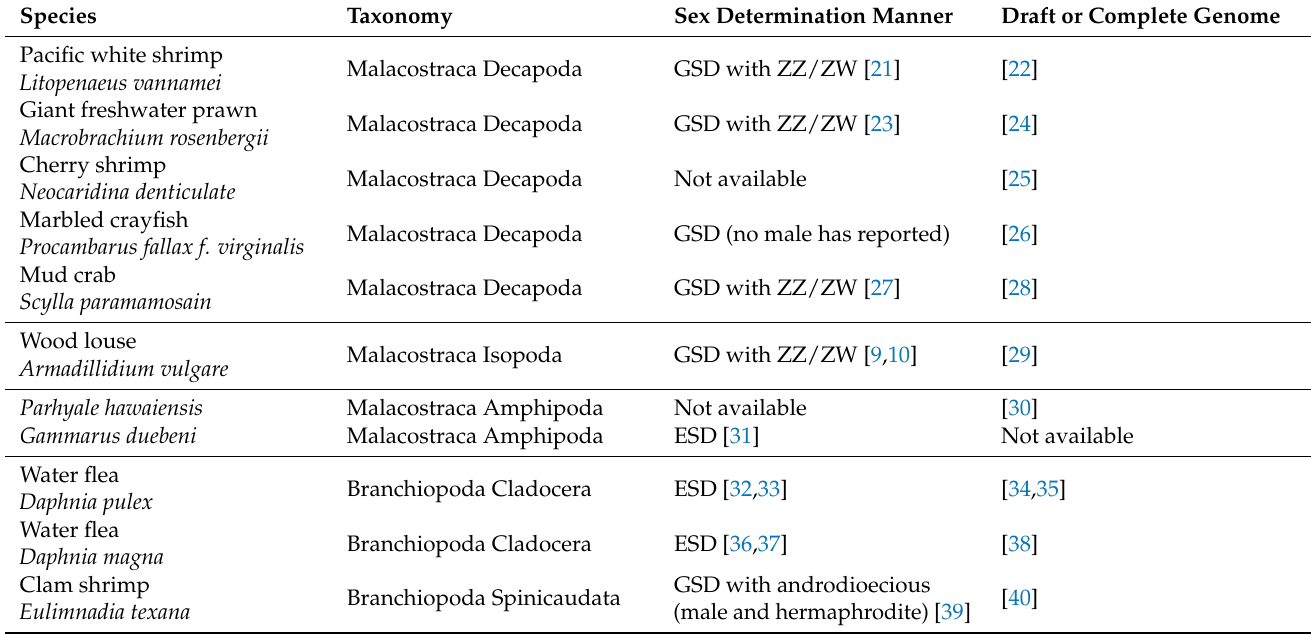
Figure 2. Schemes of sex determination and sexual development of decapods (Malacostraca) and the water flea Daphnia (Branchiopoda, cladoceran). IAG: insulin-like androgenic gland hormone, CFSH: crustacean female sex hormone, JH: juvenile hormone, DAPALR: doublesex1 alpha promoter-associated long noncoding RNA, Dsx: doublesex. Table 1. Modes of sex determination and available genome in Malacostracan and Branchiopod crustaceans.